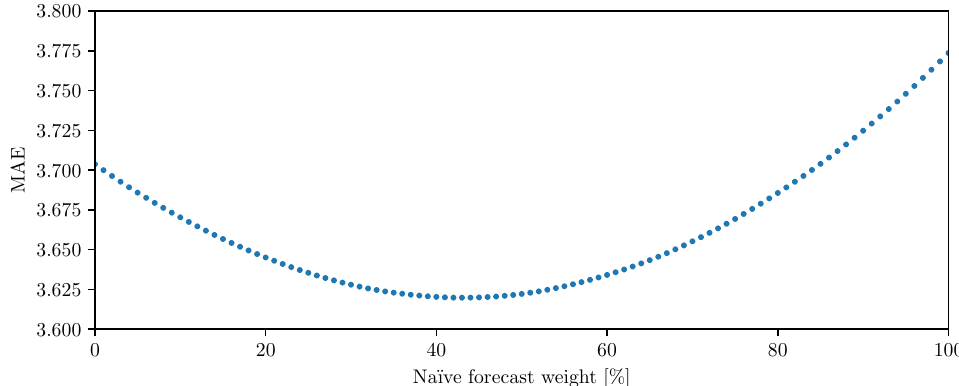
Figure 6. The MAE errors of ensembles created using Equation (18) that utilize the full model with back-transformation (4), as a function of the weight assigned to the naïve benchmark.